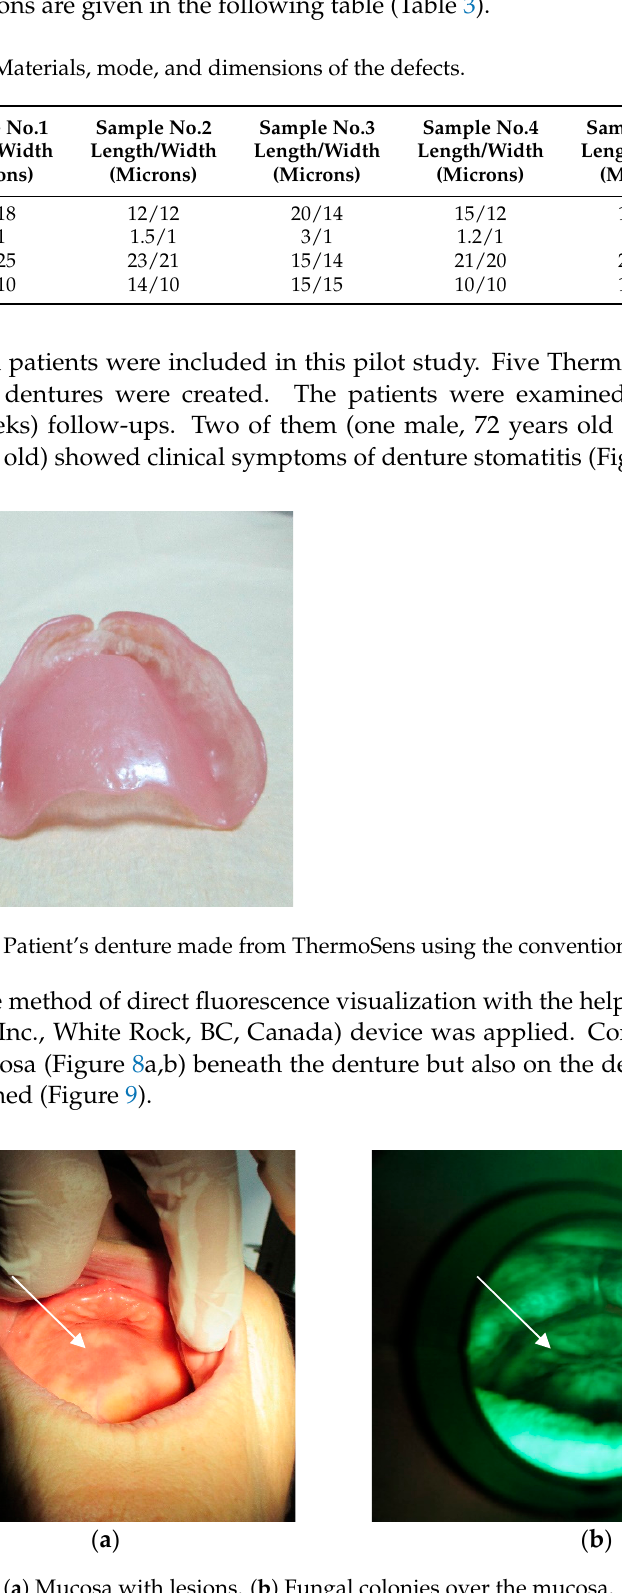
Figure 9. Colonized ThermoSens denture.